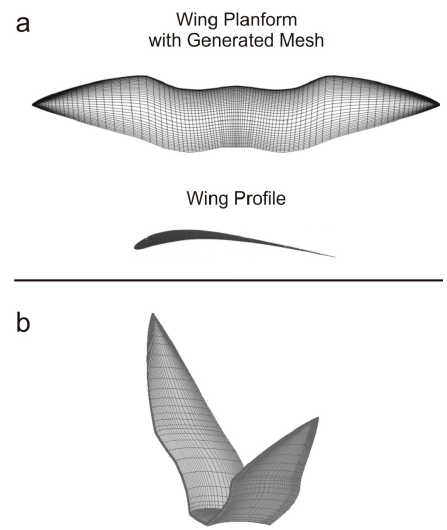
Figure 2. Wing geometry and generated mesh. ( a ) Wing planform and wing profile at zero flapping angle; ( b ) Wing at 45.0° flapping angle.